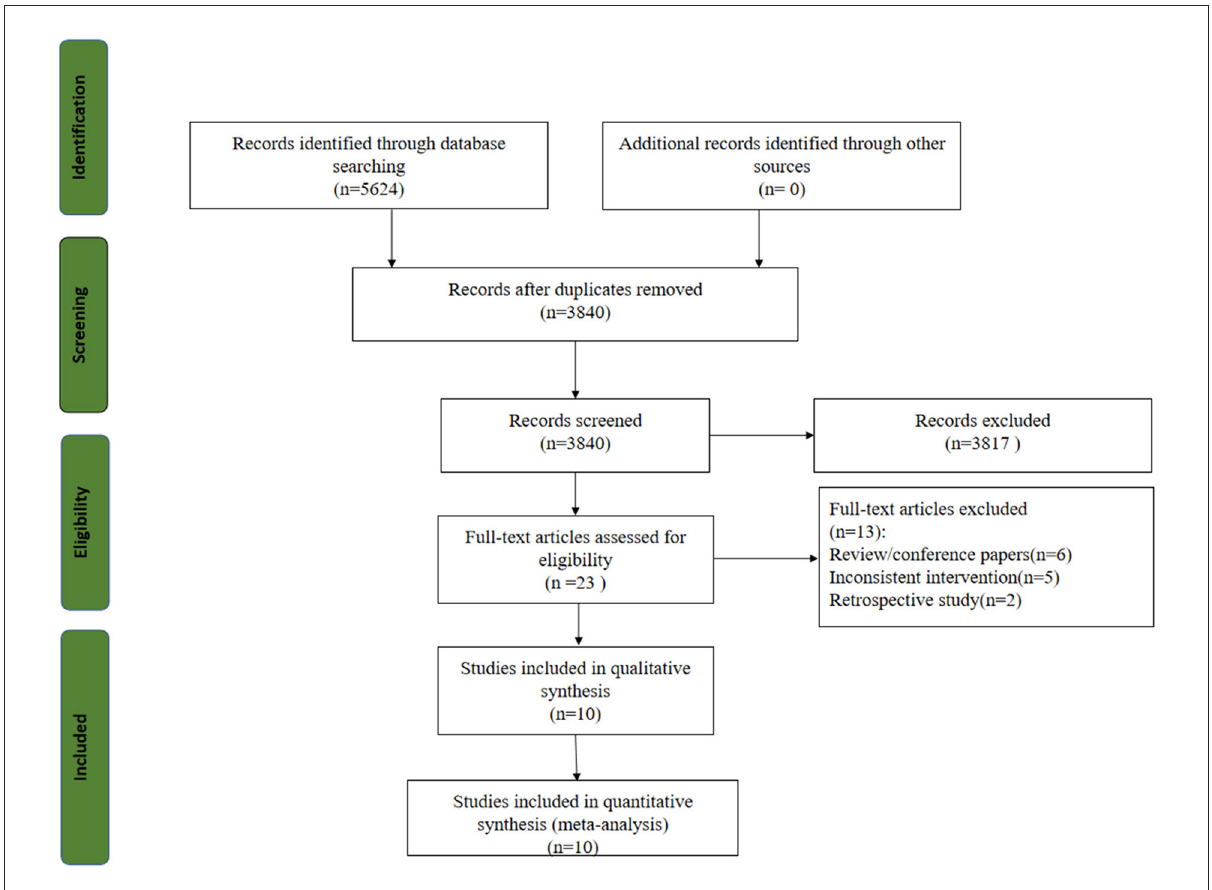
FIGURE1 Flow chart of article screening